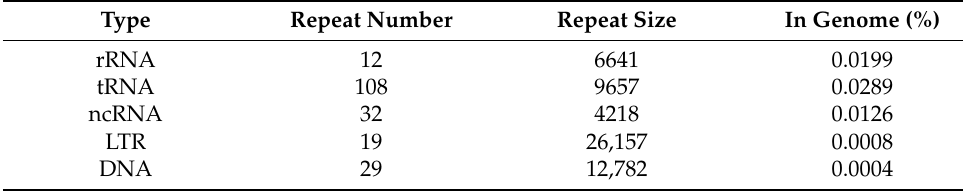
Table 3. Genomic assembly and functional annotation of strain